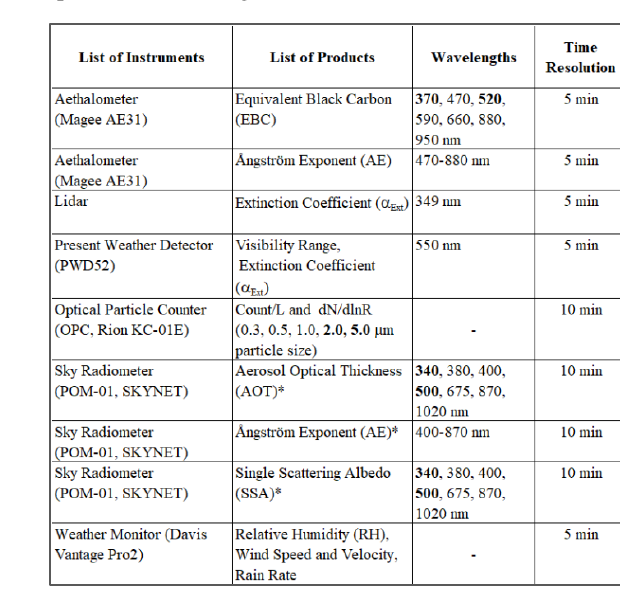
Table 1. Summary of instruments with their list of products, wavelengths and time